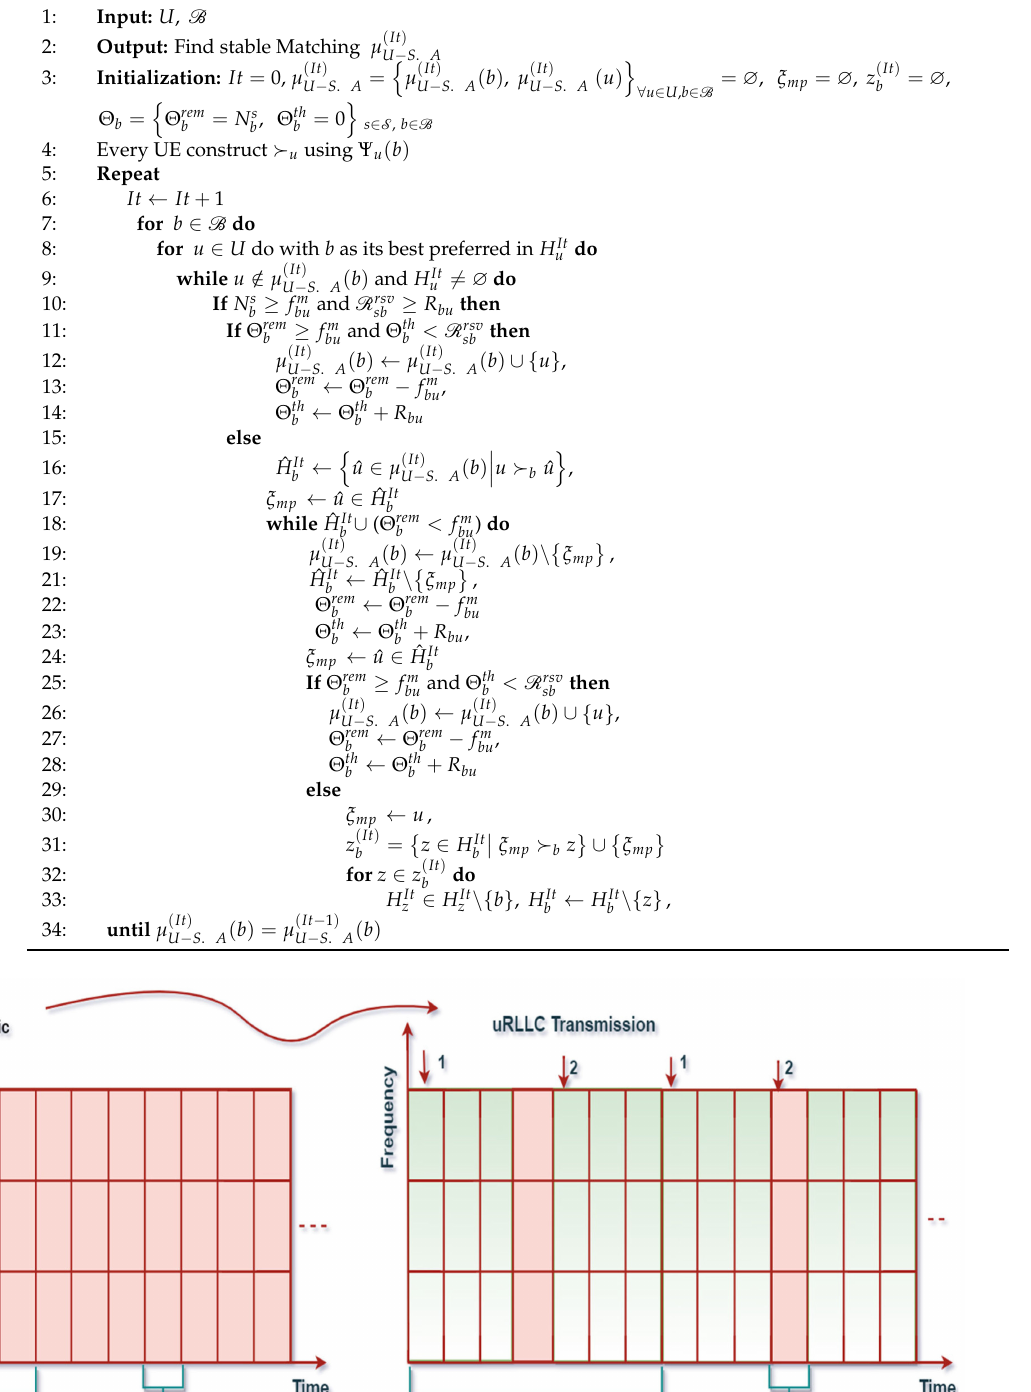
Algorithm 1: Matching Game for User-Slice Association